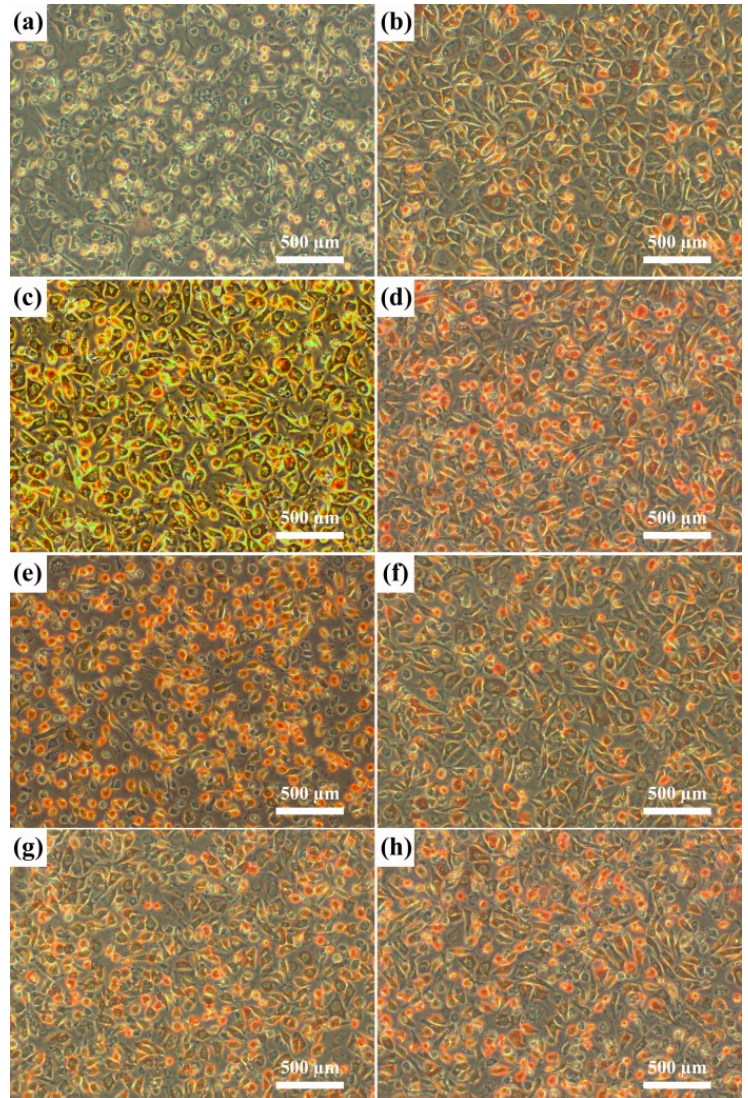
Figure 8. Photographs (×100) of the L929 cell line. ( a ) PU = polyurethane (positive control); ( b ) PE = polyethylene (negative control); ( c ) cp-Ti; ( d ) pure Nb; ( e ) Ti-5Nb; ( f ) Ti-10Nb; ( g ) Ti-15Nb; and ( h ) Ti-20Nb in the agar overlay test.